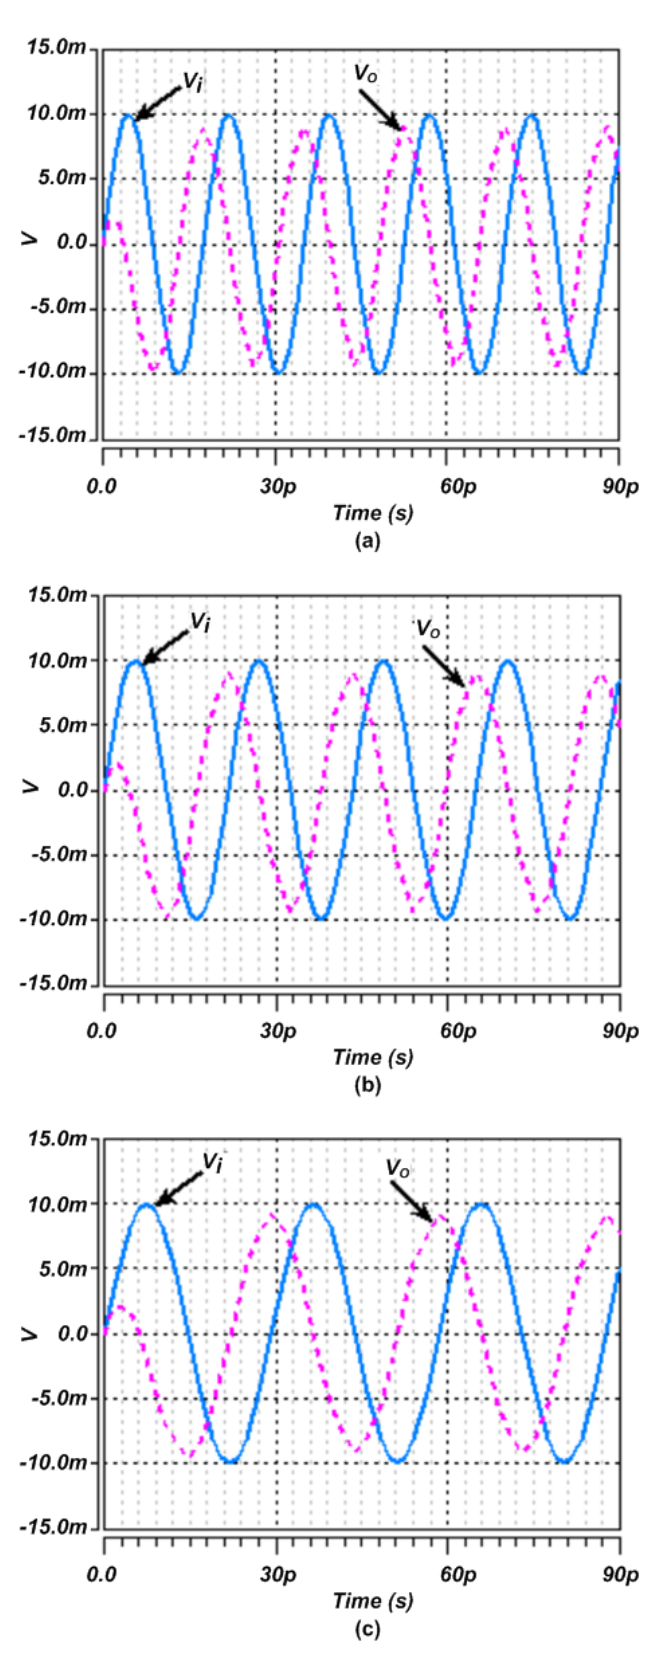
Figure 15. Transient-response of AOTAPF at different values of V tune : ( a ) − 0.30 V; ( b ) − 0.33 V; ( c ) − 0.50